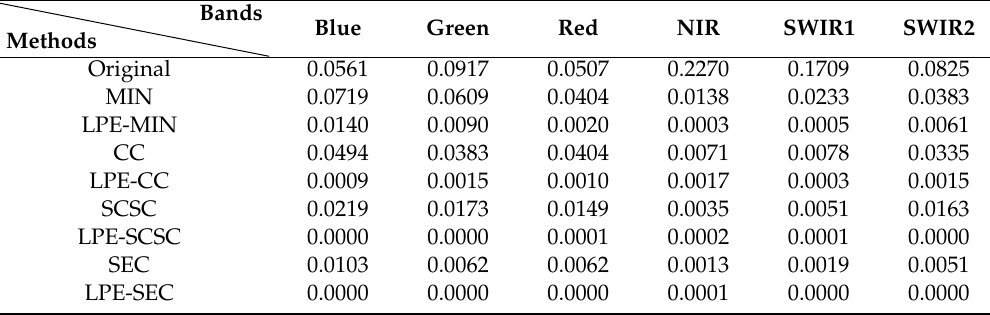
Table 5. The determination coe ffi cients values (R 2 ) of the linear relationship between IC and the reflectance for the original bands and the corrected bands obtained by traditional TC methods and LPE-TC methods.